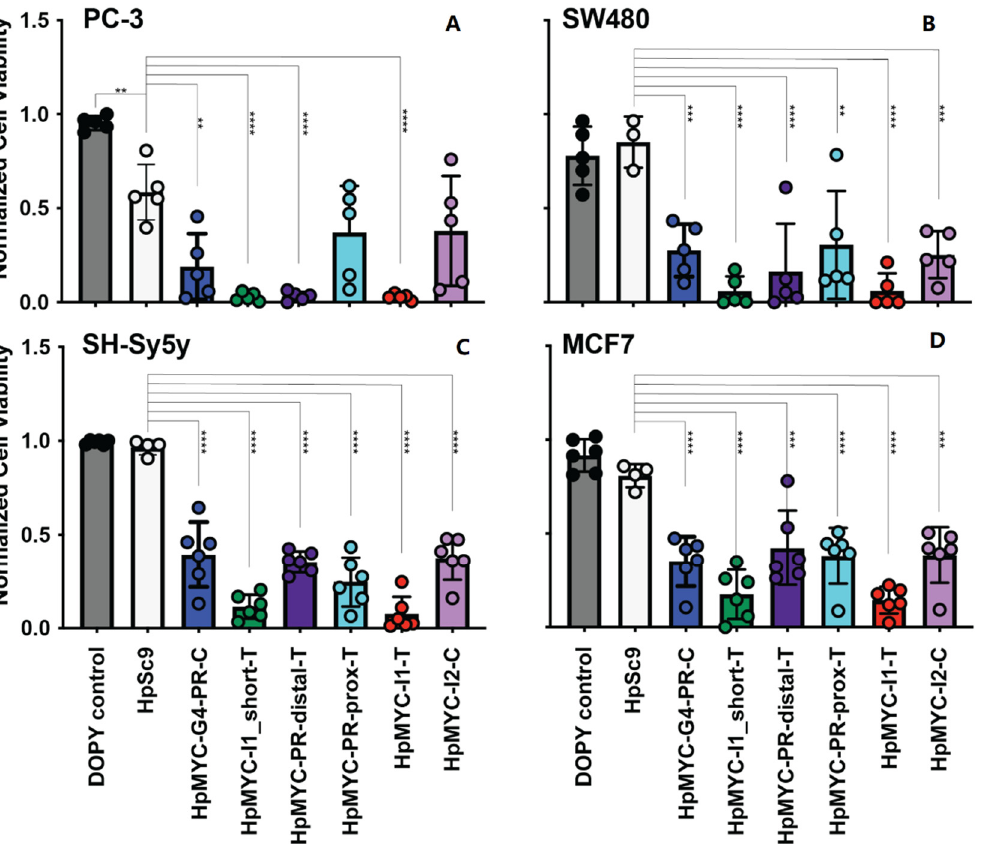
Figure 6. Effect of MYC targeting PPRHs on prostate cancer PC-3 ( A ), colorectal cancer SW-480 ( B ), neuroblastoma SH-Sy5y ( C ), and breast cancer MCF-7 ( D ), cell viability. Thus, 100 nM of PPRHs was transfected with Dioleoyl Pyridinium (DOPY). The effects of the PPRHs were determined 120 h after the transfection by cellular viability assays. PPRH effects were normalized to transfection vehicle (DOPY) control, and experiments were performed in triplicate with internal duplicates. Statistical significance was analyzed by one-way ANOVA with a post hoc Dunnett test comparing groups against the HpSc9 control; ** p < 0.01, *** p < 0.001, **** p < 0.0001.